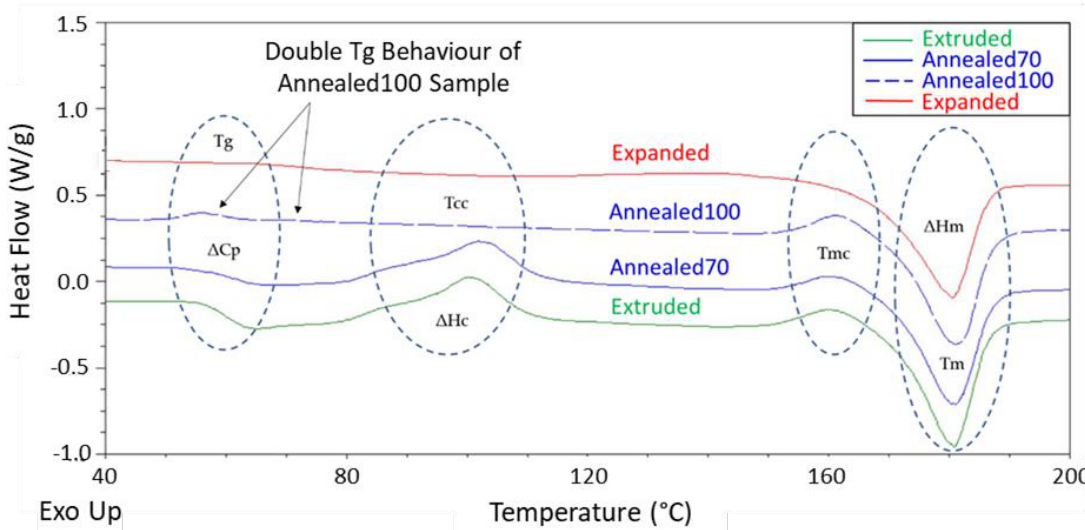
Figure 1. Differential Scanning Calorimetry (DSC) thermogram overlay of Extruded, Annealed70, Annealed100 and Expanded tubing. Abbreviations: T g : glass transition temperature; ∆ C p : specific heat change; T cc : cold crystallisation; ∆ H c : enthalpy of cold crystallisation; T mc : melting recrystallisation; T m : melting temperature; ∆ H m : enthalpy of melting; X c : the degree of crystallinity.